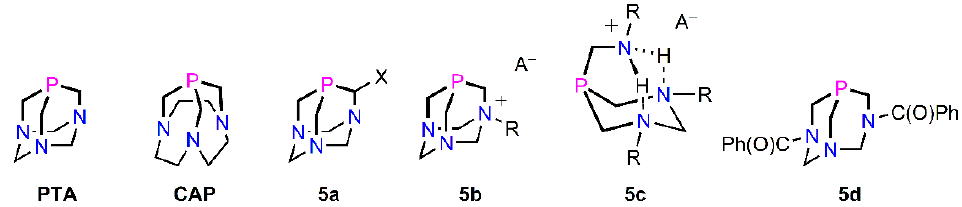
Figure 7. Selected examples of PTA, CAP, and related compounds (A =